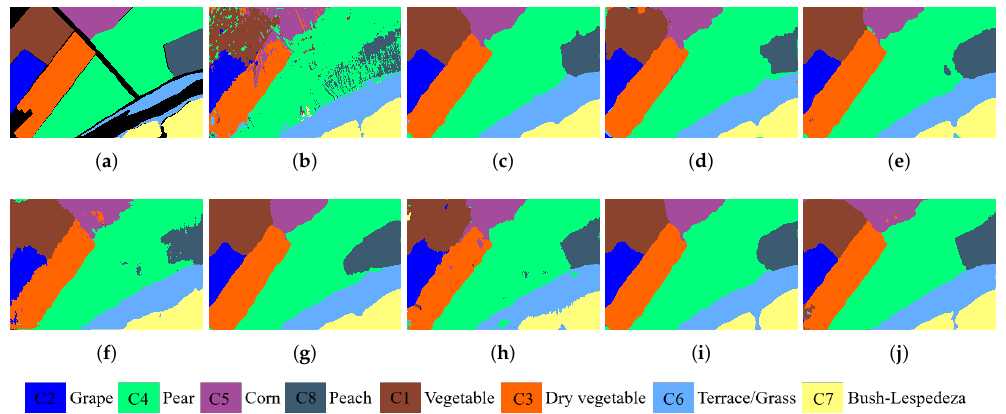
Figure 10. Map of the classification results from all approaches on ZY. ( a ) ground truth. ( b )